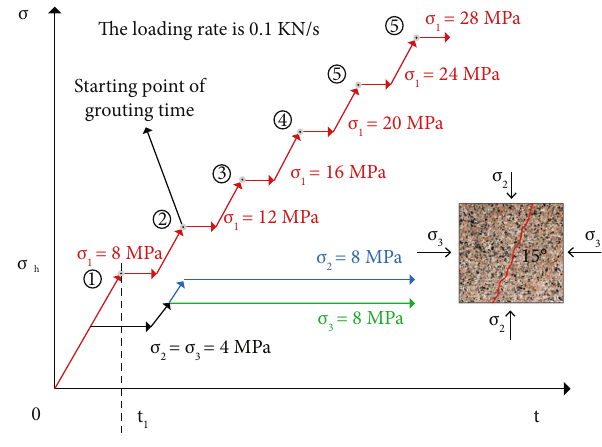
Figure 7: Loading path and grouting